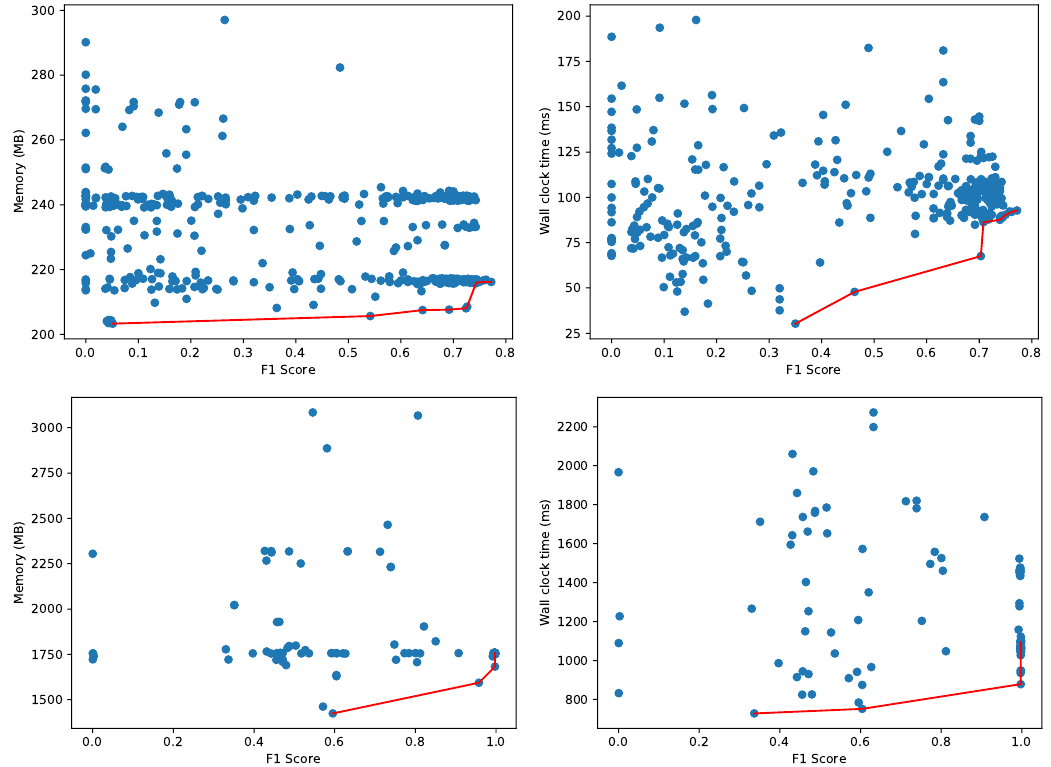
Figure 9. Pareto fronts for memory ( left ) and wall clock time ( right ) for the Agots synthetic dataset ( top ) and CICIDS 2017 dataset ( bottom